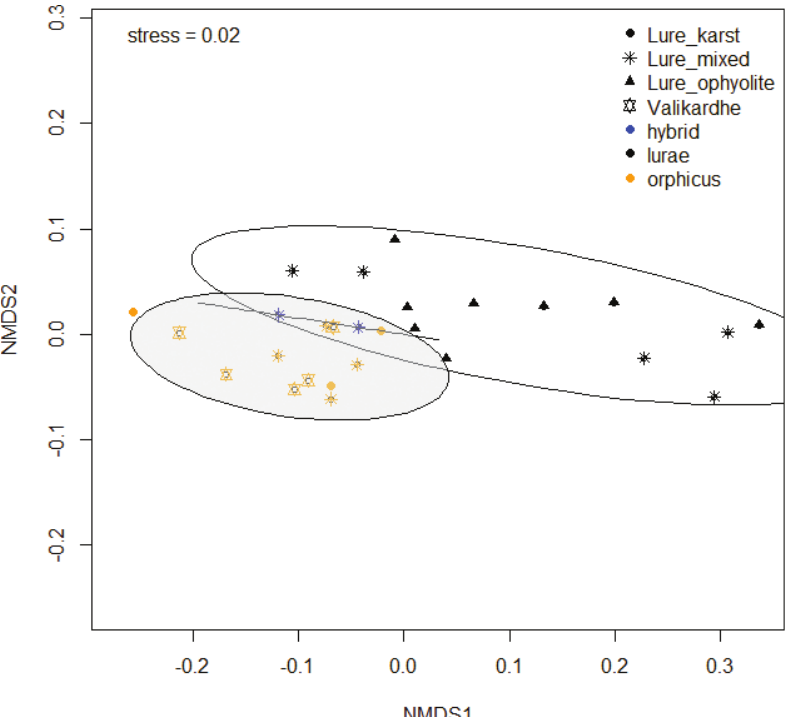
Figure 9. NMDS plot representing the morphometric analysis of dorsal male wings reflectance measure- ments of P. orphicus (orange dots) and P. lurae sp. nov (black dots). Stress = 0.02; specimens indicated in blue are potential P. lurae × P. orphicus hybrids collected in the contact zone and showed intermediate wing reflectance. Different symbols represent collection sites of three studied habitat with different substrate types (ophiolitic, karst, mixed). Ellipses represent 95% confidence intervals of specimen groups ‘orphicus’, ‘lurae’ and